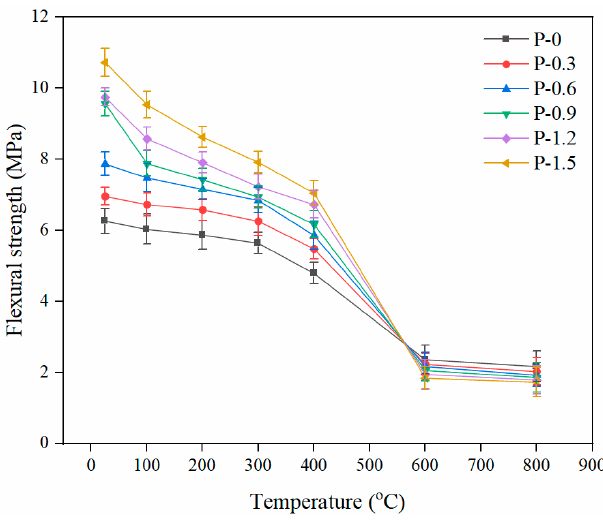
Figure 9. Flexural strength of PVA-FRCC specimens with different fiber contents.